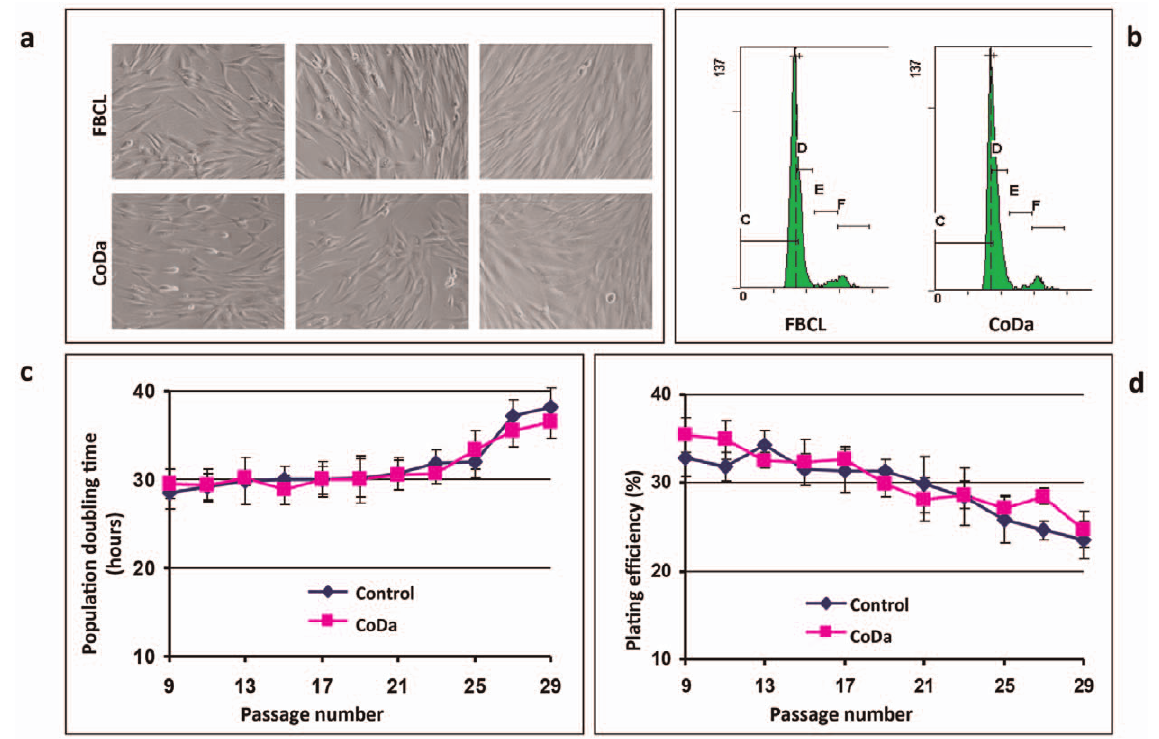
Figure 2. Primary culture of human fibroblasts. Fibroblast cell lines, designated CoDa, were established from the autopsy skin tissues. Panel a shows the representative images of a normal fibroblast control line (FBCL) and CoDa cells in in vitro culture. Images were taken under bright field microscopy with various confluences. Panel b shows the cell cycle distribution of fibroblasts in log-phase of in vitro culture, based on flow cytometry analysis of the DNA content. Panels c and d show population doubling time (panel c) and plating efficiency (panel d) of CoDa and control fibroblasts in vitro . Shown are averages of 2–3 independent experiments with CoDa-33 and FBCL cells. Error bars are standard errors.